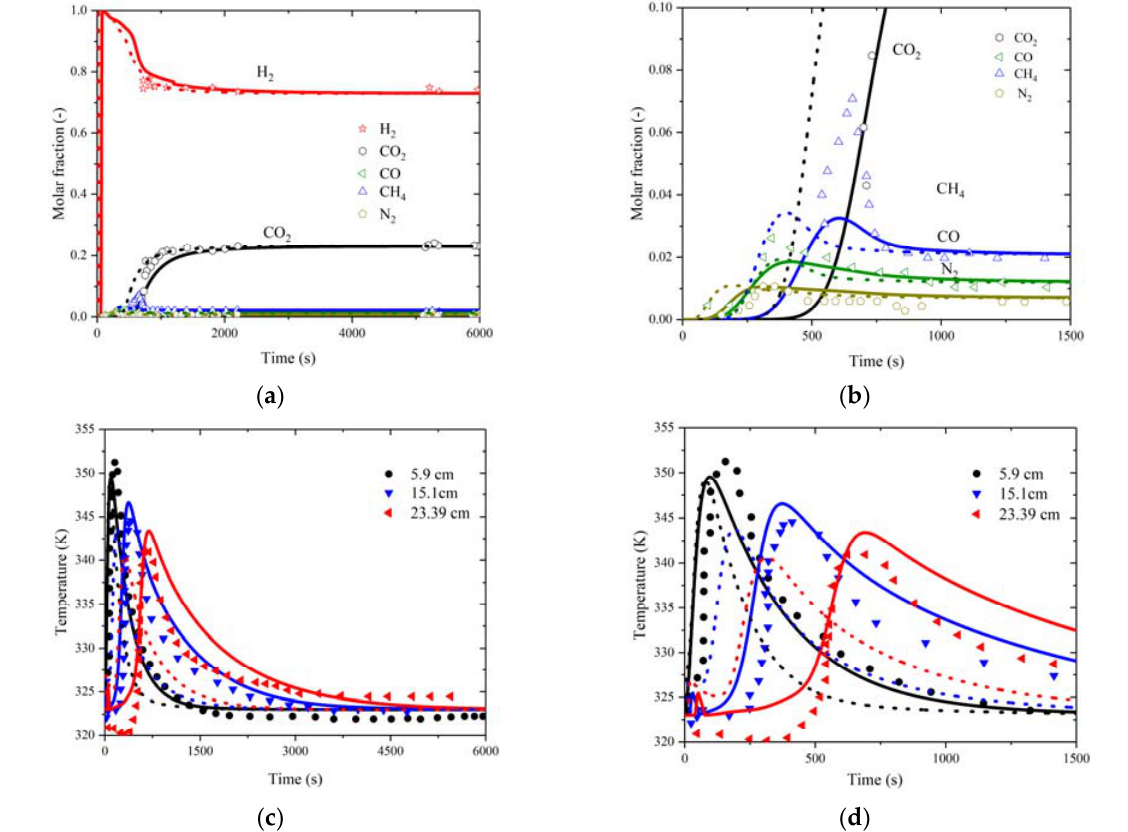
Figure 2. Breakthrough curves ( a , b ) and temperature profiles ( c , d ) on AC5-KS and R2030. Symbols: Experimental data for AC5-KS from [35]. Lines: Simulation results for AC5-KS (—) and R2030 (- - -).